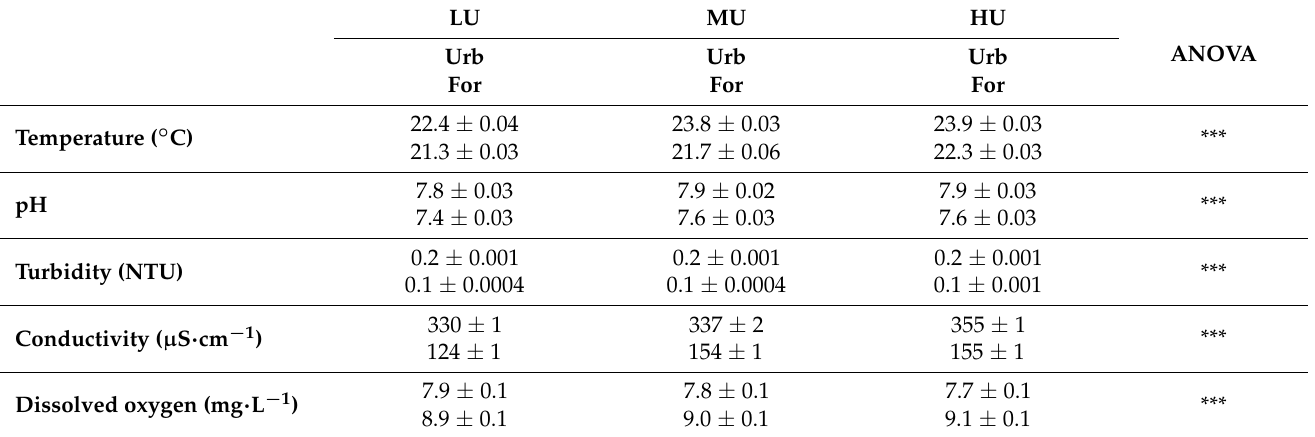
Table 3. Mean ( ± SE) physicochemical measurements in low urban (LU), medium urban (MU), and high urban (HU) reaches in the Urb (urban stream, R í o Piedras) and For (forested stream, R í o Sabana) watersheds (*** p <